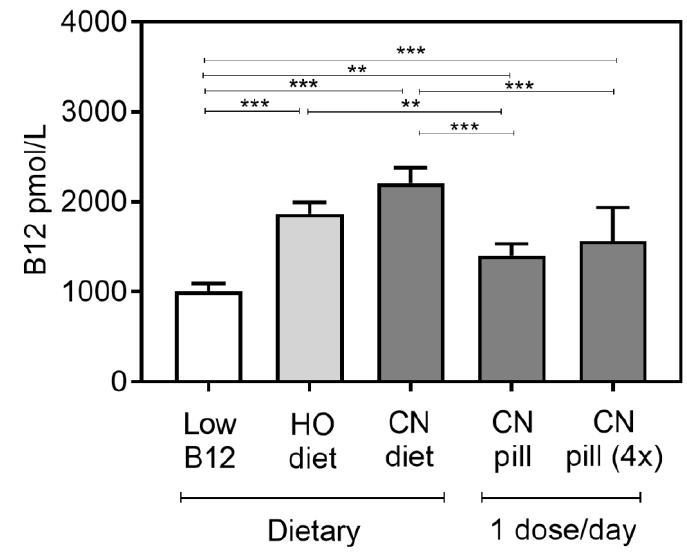
Figure 5. The sum of all B12 recovered in liver, kidney, and brain. Results are shown as median with interquartile range. Tissues were measured for content of B12 and whole-organ B12 was calculated from the B12 content (pmol/g of wet tissues) and the total organ weights. Muscle was not included, as we did not measure the total muscle mass. The one-way ANOVA with Tukey’s post hoc corrections for multiple comparisons was used to compare groups. Asterisks indicate the level of statistical significance ( p < 0.0005 (***), p < 0.005 (**), and p < 0.05 (*)). The tissue B12 contents between the five groups (B12 per gram tissue) are compared in Figure 4.